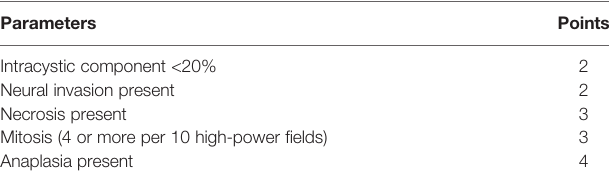
TABLE 1 | Grading parameters and point values for esophageal mucoepidermoid carcinoma.